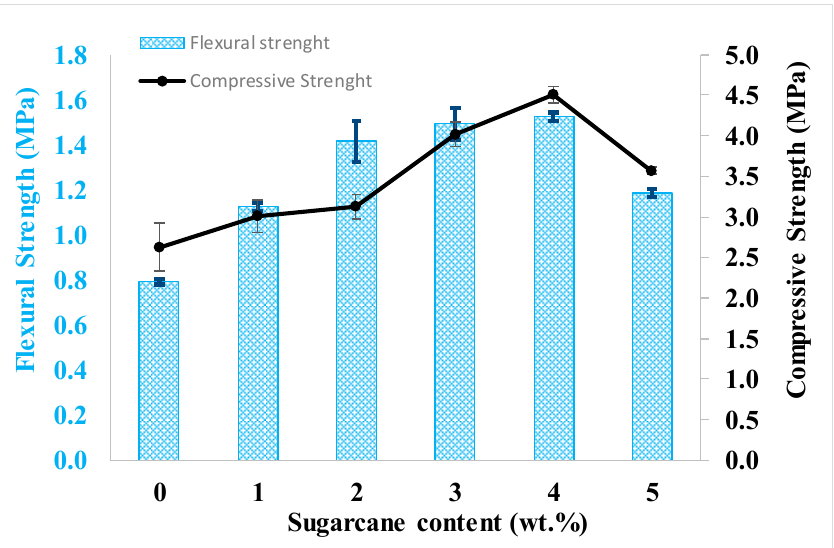
Figure 14. Compressive and flexural strengths of adobes reinforced with sugarcane bagasse.